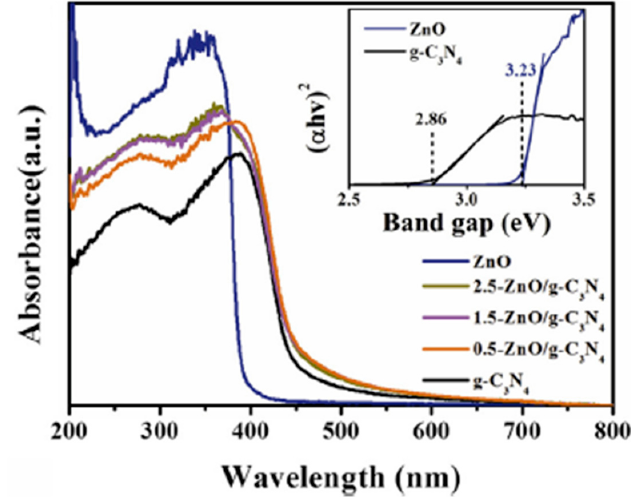
Figure 6. UV–Vis absorption spectra of ZnO, g-C 3 N 4 , and ZnO/g-C 3 N 4 samples with different ZnO content. The insert spectrum is the Tauc plots of ZnO and g-C 3 N 4 . Reprinted from reference [23], Copyright 2019 Elsevier.